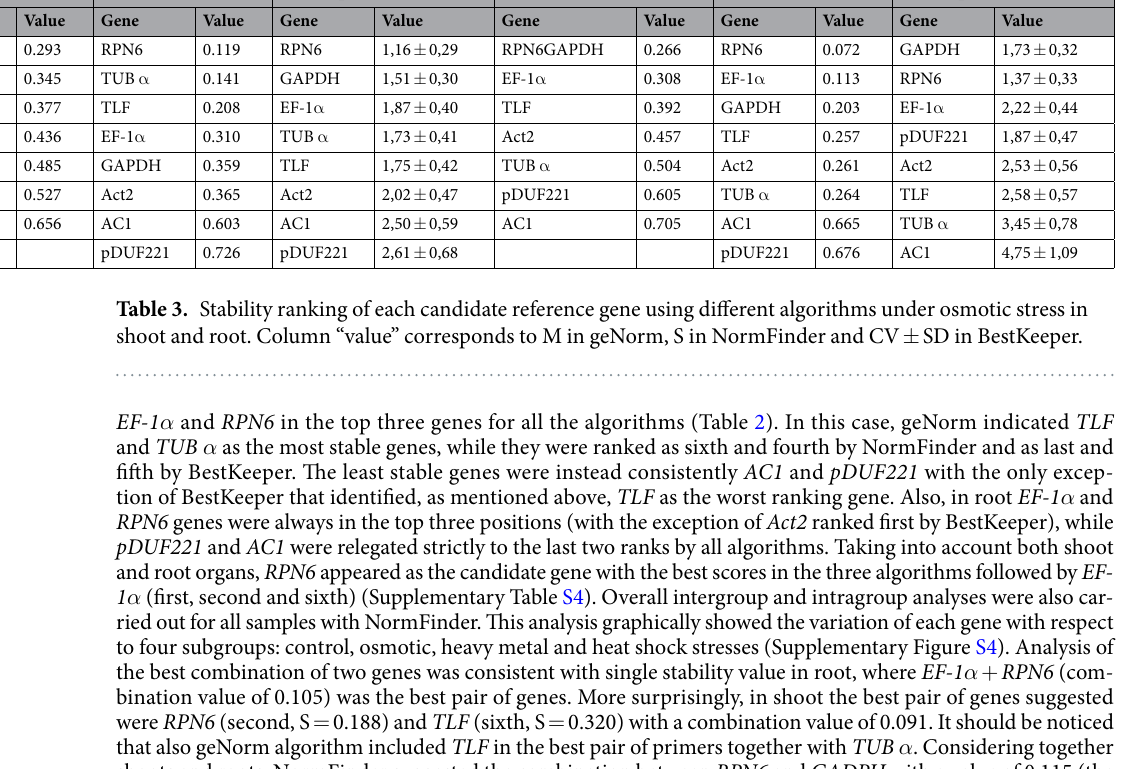
EF-1 α and RPN6 in the top three genes for all the algorithms (Table 2). In this case, geNorm indicated TLF and TUB α as the most stable genes, while they were ranked as sixth and fourth by NormFinder and as last and fifth by BestKeeper. The least stable genes were instead consistently AC1 and pDUF221 with the only excep- tion of BestKeeper that identified, as mentioned above, TLF as the worst ranking gene. Also, in root EF-1 α and RPN6 genes were always in the top three positions (with the exception of Act2 ranked first by BestKeeper), while pDUF221 and AC1 were relegated strictly to the last two ranks by all algorithms. Taking into account both shoot and root organs, RPN6 appeared as the candidate gene with the best scores in the three algorithms followed by EF- 1 α (first, second and sixth) (Supplementary Table S4). Overall intergroup and intragroup analyses were also car- ried out for all samples with NormFinder. This analysis graphically showed the variation of each gene with respect to four subgroups: control, osmotic, heavy metal and heat shock stresses (Supplementary Figure S4). Analysis of the best combination of two genes was consistent with single stability value in root, where EF-1 α + RPN6 (com- bination value of 0.105) was the best pair of genes. More surprisingly, in shoot the best pair of genes suggested were RPN6 (second, S = 0.188) and TLF (sixth, S = 0.320) with a combination value of 0.091. It should be noticed that also geNorm algorithm included TLF in the best pair of primers together with TUB α . Considering together shoots and roots, NormFinder suggested the combination between RPN6 and GADPH with a value of 0.115 (the latter classified at the sixth position as a single gene) (Supplementary Figure S4C). These differences with respect to the results of the gene by gene analyses were due to the fact that NormFinder tended to enhance intergroup stability by balancing over/under expression of the two genes to be as close as possible to zero in each subgroup. Expression stability analyses of candidate reference genes under water/osmotic stress treat- ment. Water stress was induced by adding 15% of PEG 6000 to the hydroponic solution which decreased the osmotic pressure of the media, consequently inducing osmotic and water limitation stress in the plants 31 without toxic effects in the short term 32 . Reference gene analyses under this simulated drought condition in A. donax shoots showed a high and shared rank for RPN6 (first in NormFinder and BestKeeper, second in geNorm) followed by EF-1 α gene (first in geNorm, fourth in NormFinder and third in BestKeeper) (Table 3). In roots, RPN6 was confirmed as the most stable gene followed by GAPDH that had the best value in geNorm (shared with RPN6 ) and BestKeeper. Using both organ’s samples, RPN6 and GADPH were the best two genes (Supplementary Table S4), resulting in the top three ranks provided by all programs. The lowest stability values resulted from the AC1 and pDUF221 genes with all algorithms and tissues with exception of BestKeeper that ranked pDUF221 at the fourth position in root and TLF and EF-1 α as last in the shoot + root analysis.